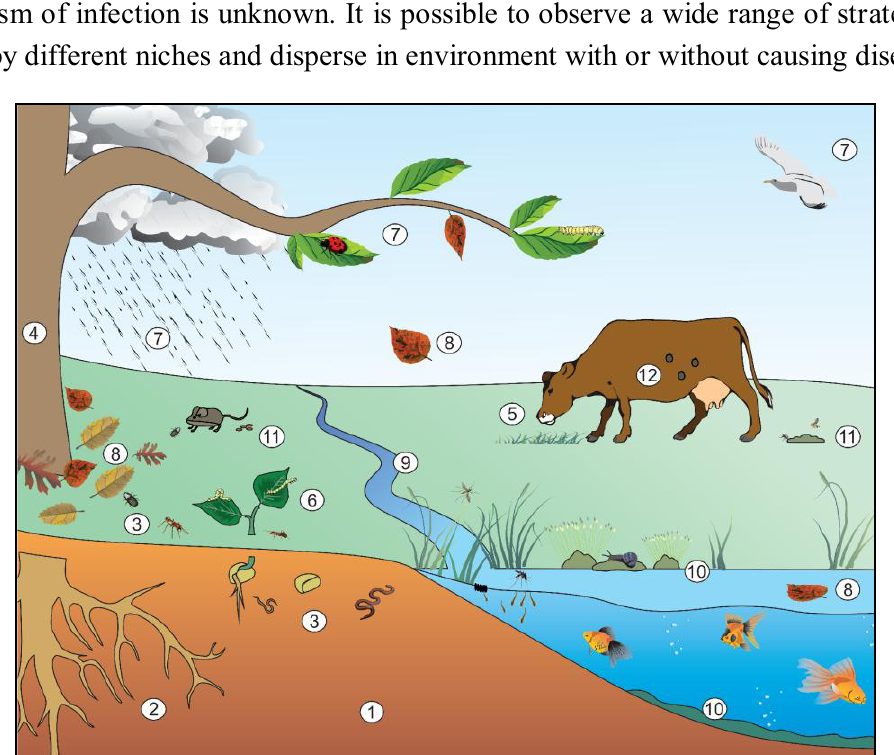
define pathogenicity; other toxi-infection pathogenic symptoms, such as delays in development, lack of pupation, body deformations in adults etc. , can also be used to evaluate different types and/or intensities of pathogenic effects under play. Therefore, it appears to be very difficult to be absolutely